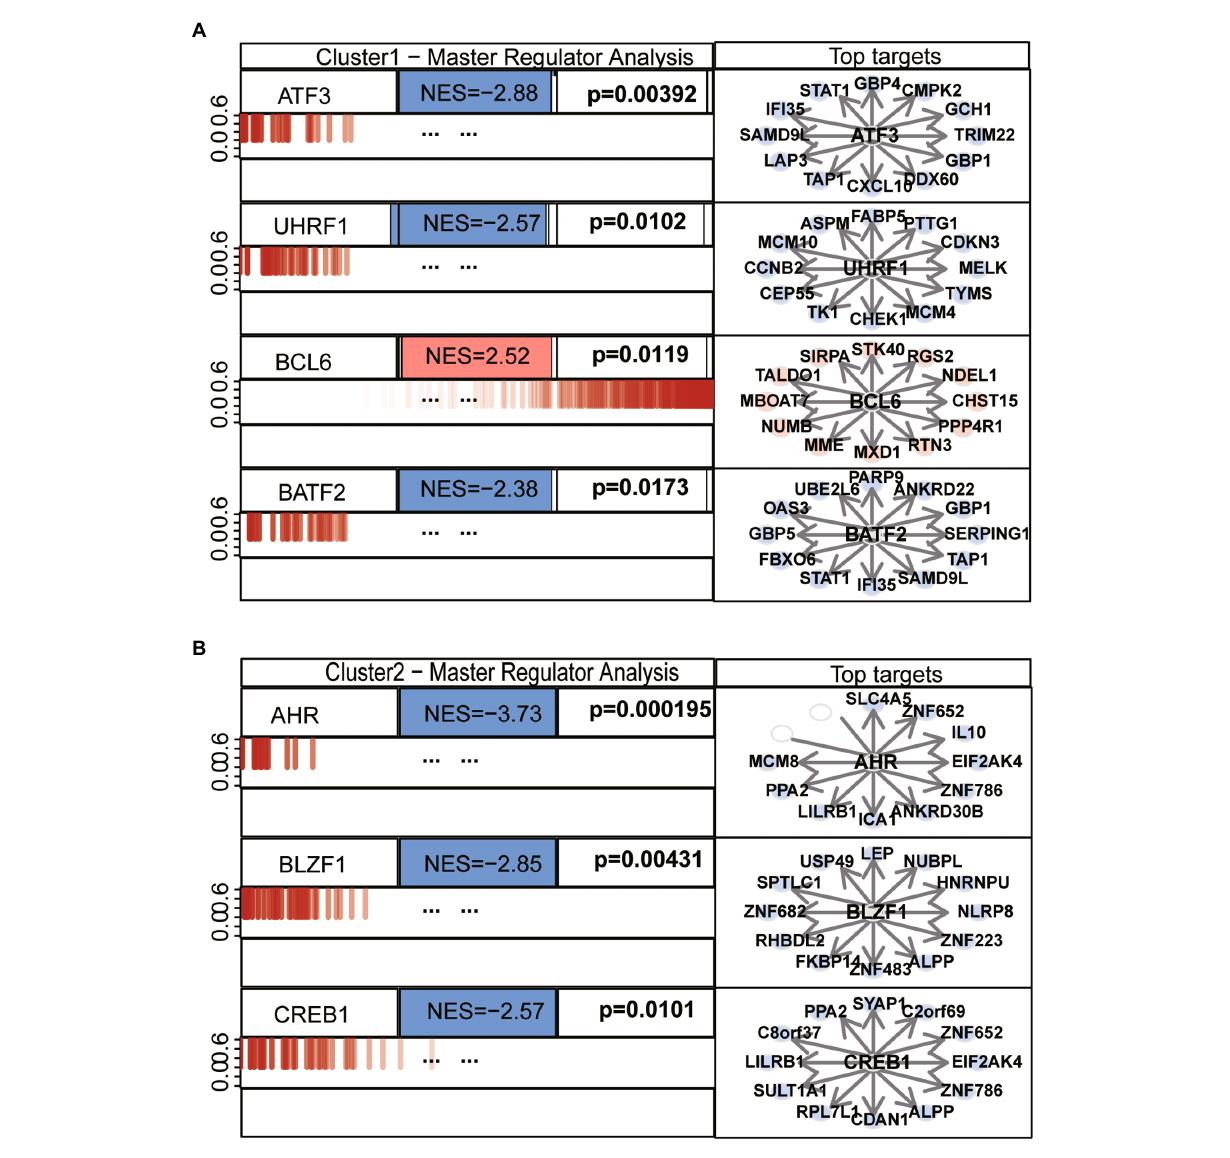
FIGURE 8 Top master regulators of ASD clusters. (A) Master regulatory analysis of ASD subcluster 1. (B) Master regulatory analysis of ASD subcluster 2. Each network is indicated by its master regulators. A barcode-like diagram displaying all transcriptome genes, from most downregulated (left) to most upregulated (right), is used to display the genes in each network (right). Targets with positive (red) and negative (blue) correlations are overlaid as bars of different colors on the differential expression signature. p -values and normalized enrichment scores (NES) are also shown. The 12 most likely network putative targets of each MR are shown to the right in red if they are upregulated or blue if they are downregulated, with a pointed arrow indicating that they are predicted to be activated by the centroid protein and a blunt arrow indicating that they are predicted to be